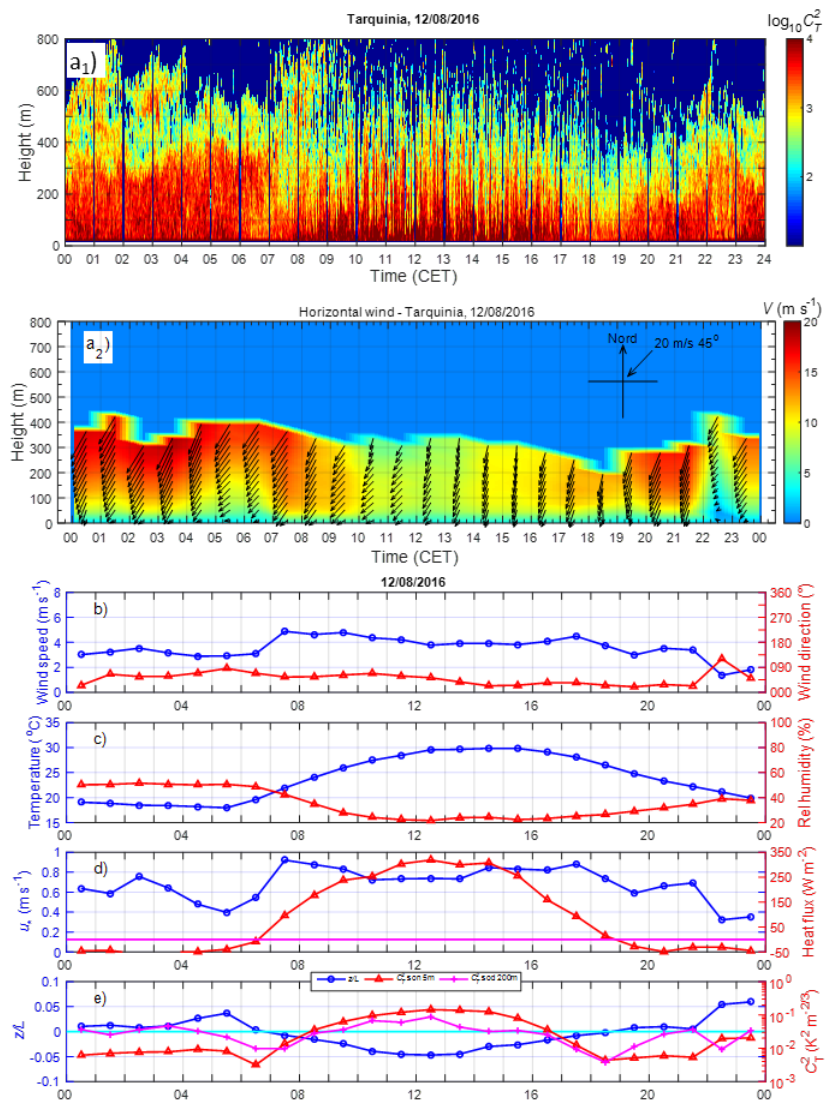
Figure 15. Example of the diurnal variation of the ( a 1 ) ABL thermal turbulence and ( a 2 ) wind field structures; ( b ) wind speed and direction at 5 m; ( c ) temperature and relative humidity; ( d ) friction velocity and sensible heat flux; and ( e ) the stability parameter z/L at 5 m and the temperature structure parameter C T 2 at 5 m (from the sonic anemometer) and at 200 m (from the sodar, in arbitrary units) on 12 August 2016.